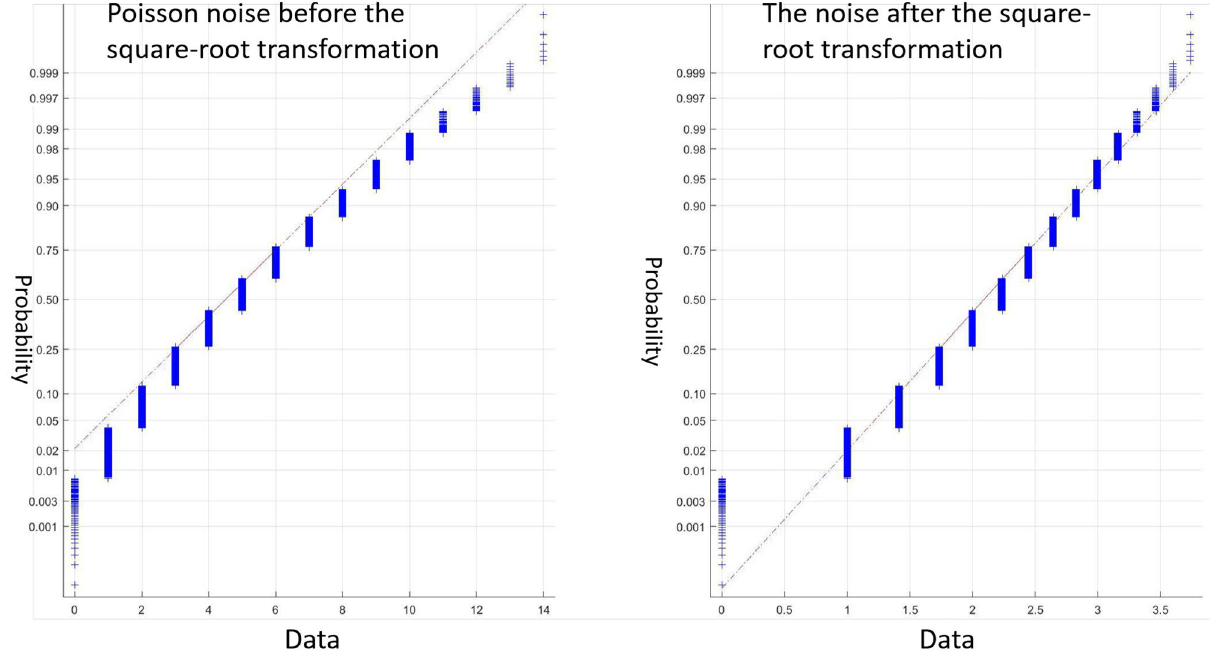
Figure 2. The normal probability plots for the Poisson noise and the transformed noise after square-root transform. It can be seen that after the transform, the data fit better to a Gaussian